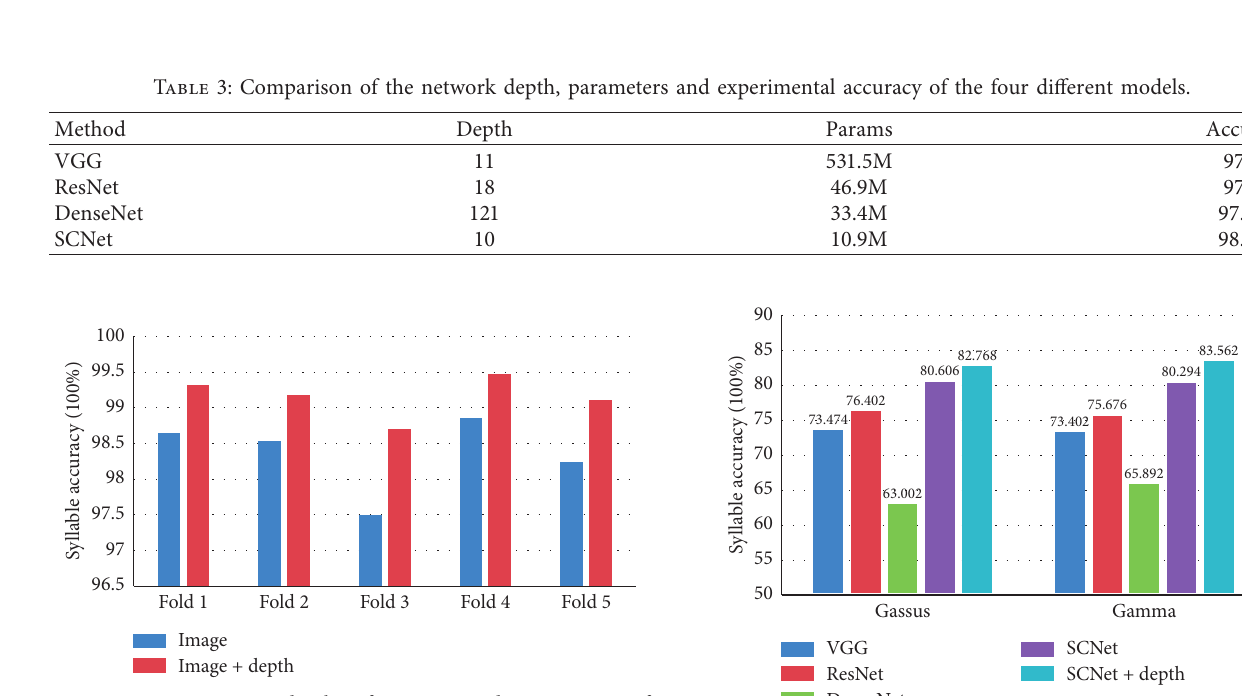
Figure 6: Vowel tone results of different models. The influence of (a) different methods and (b) different skip connections on the accuracy of vowel recognition.